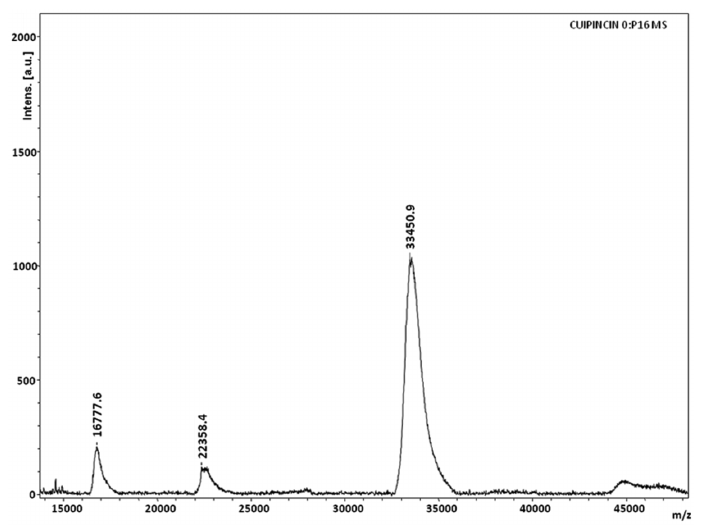
Fig 4. MALDI-TOF spectrum of cupincin. Protein sample was mixed in equal volume 1:1 with matrix Sinapinic acid 50% Acetonitrile and water with 0.1% TFA and spotted on the target plate and air dried. MS spectrum was obtained using UltrafleXtreme, Bruker Daltonics spectrometer operating in linear and positive ionization mode with Flex control software.